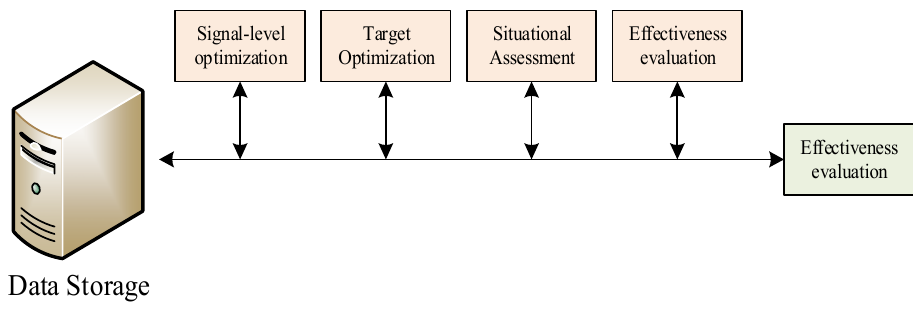
Figure 4. Data fusion model.